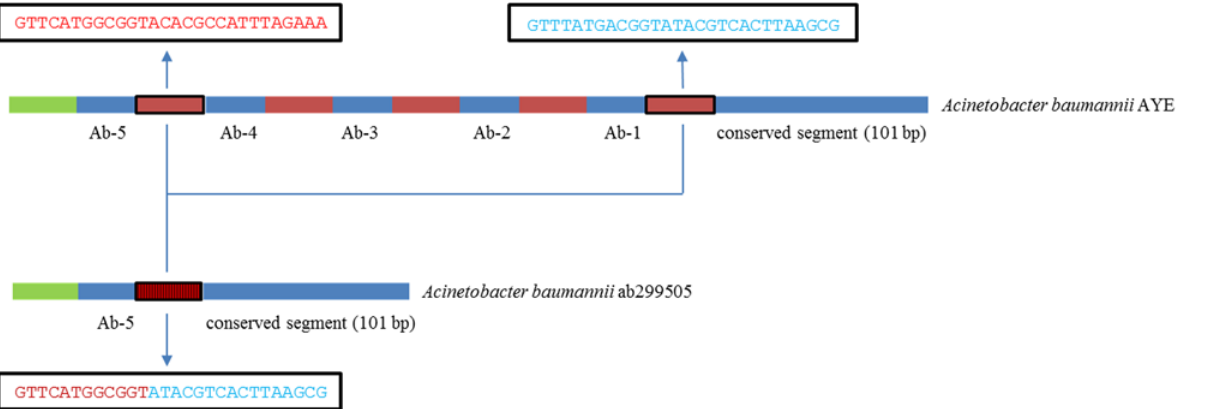
Fig 2. Schematic comparison of the trailer end of the arrays of spacers in Acinetobacter baumannii AYE and A . baumannii ab299505. The region carrying spacers Ab-1 to Ab-4 in A . baumannii AYE was missing in A . baumannii ab299505, most likely due to an internal deletion caused by a recombination event between the two direct repeats (highlighted by a black frame) surrounding the deleted region. This created a unique direct repeat (highlighted by a black frame and vertical lines) characterized by a novel mosaic sequence derived from the recombined direct repeats. Sequence of the direct repeats involved in the recombination was presented in adjacent black